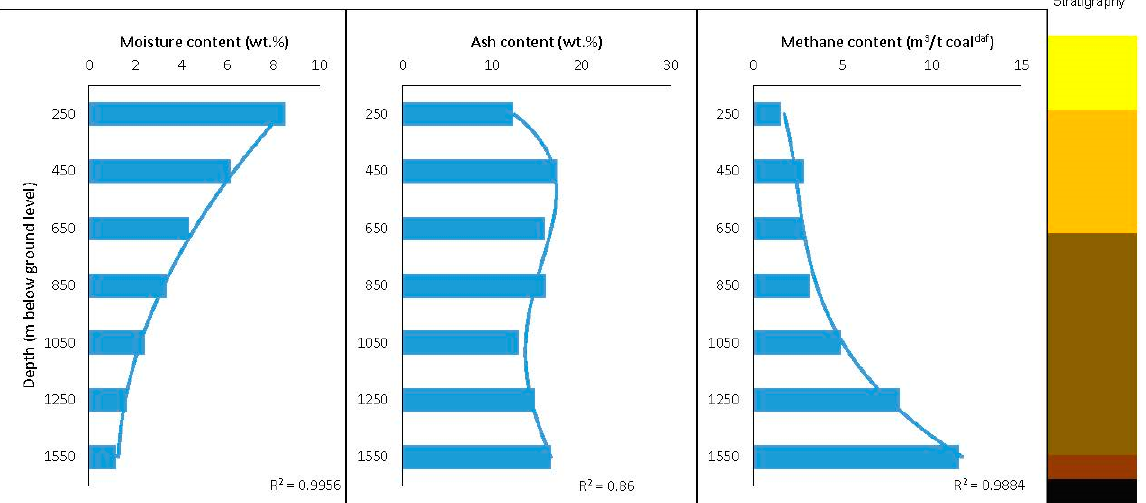
Figure 6. epth trends of average moisture, ash and methane contents related to stratigraphy in sub-area 2 (Dankowice). Explanations as in Figure 5.